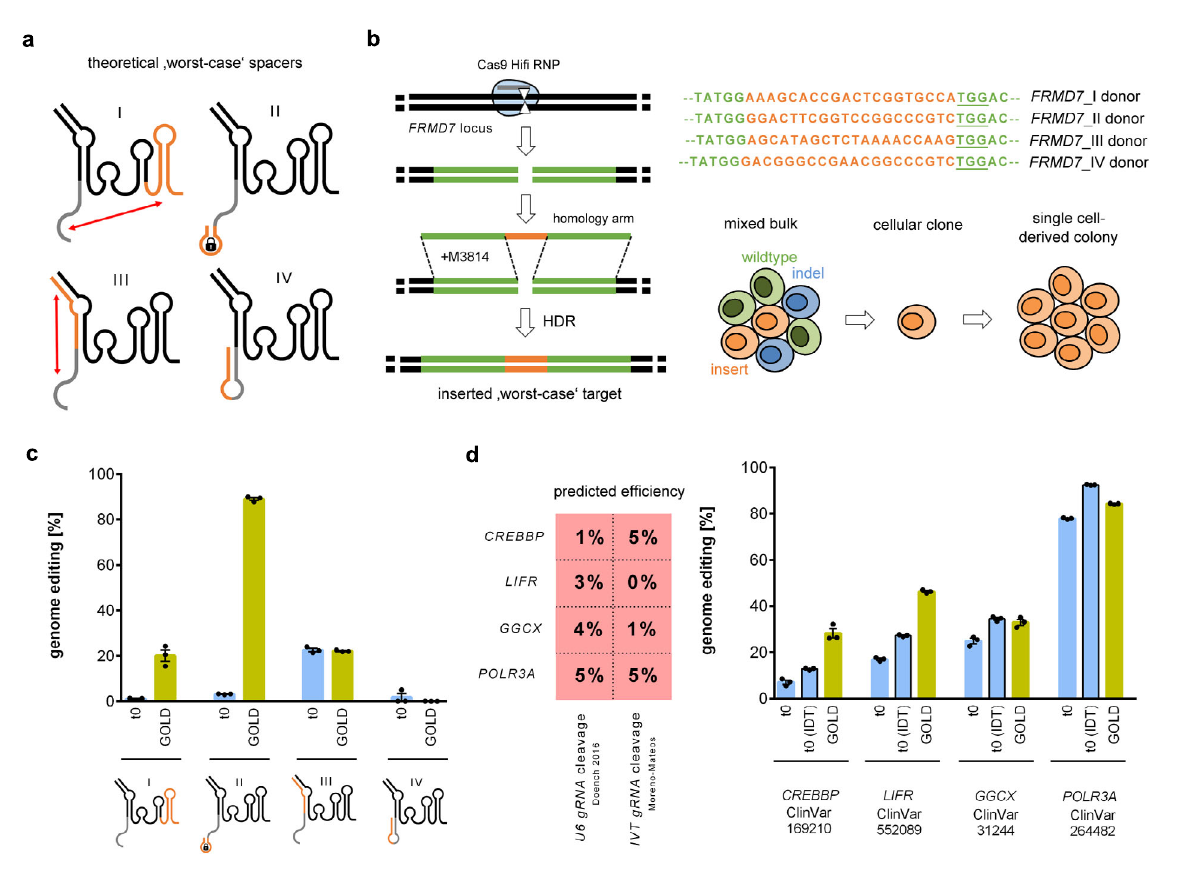
Fig. 3 Genome editing ef fi ciencies of predicted low performance gRNAs. a Sketches of theoretical ‘ worst-case ’ spacers where the spacer is perfectly complementary to the 3 ′ end of the tracrRNA (roman numeral I), forms the locked hairpin with itself (roman numeral II), is perfectly complementary to the 3 ′ end of the crRNA (roman numeral III), or forms a perfect hairpin along the whole spacer sequence (roman numeral IV). The complementary region is colored orange and expected interactions are presented as hairpins or indicated by red arrows. b Strategy to introduce the theoretical ‘ worst-case ’ spacer target sequences from c into 409-B2 iCRISPR hiPSCs. Cleavage of the FRMD7 locus by Cas9 HiFi RNP is followed by subsequent HDR using a ssODN donor sequence carrying the intended target site next to a TGG PAM. M3814 is added to block NHEJ and increase HDR ef fi ciency. Four different edits are done for target insertions I – IV followed by generation of single cell-derived cellular clones. c Genome editing ef fi ciency of theoretical ‘ worst-case ’ gRNAs from a and t0 or GOLD tracrRNA. gRNAs were electroporated into Cas9 expressing 409-B2 iCRISPR hiPSCs that carry the corresponding inserted ‘ worst-case ’ target in the FRMD7 locus. d Genome editing ef fi ciency of gRNAs adjacent to a disease-relevant ClinVar site and predicted to be self-complementary and to have very low cleavage ef fi ciency (Doench 2016 and Moreno-Mateos percentile score both ≤ 5). Compared are t0 (normal), t0 (IDT) with proprietary chemical modi fi cations, and GOLD tracrRNA. Cas9 RNPs were electroporated into 409-B2 hiPSCs. Independent biological replicates ( n = 3) are depicted by black dots and the error bars show the SEM. Source data are provided as a Source Data